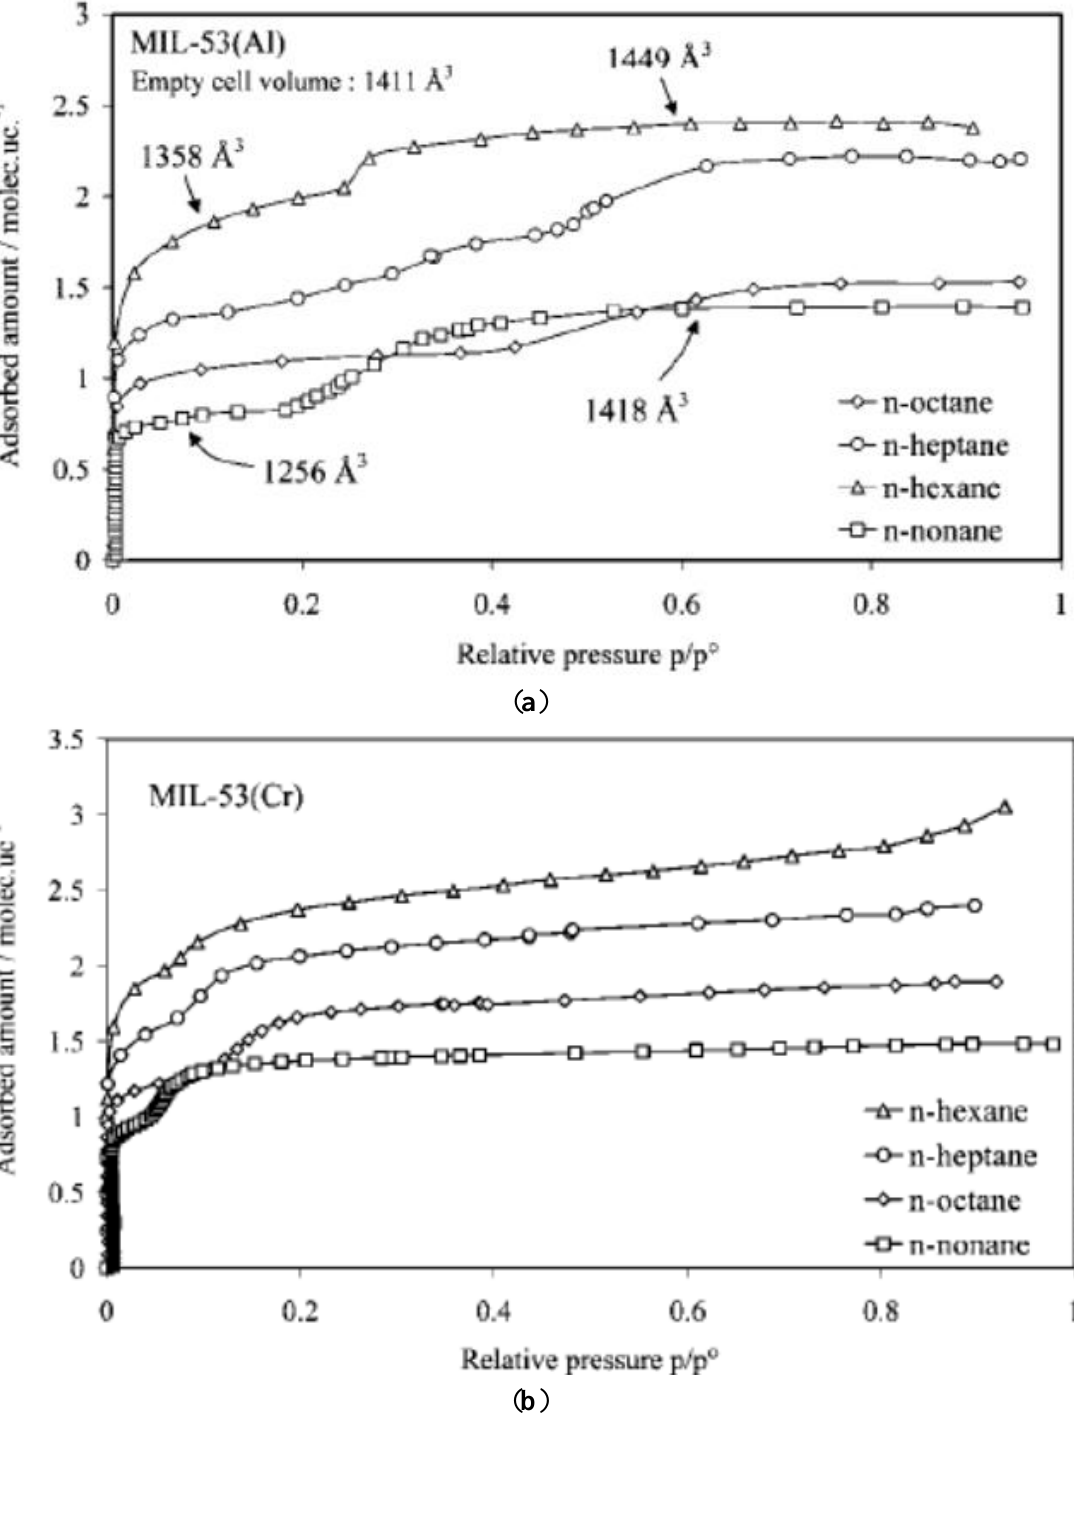
Figure 14. Adsorption isotherms of n -alkanes at 313 K. ( a ) MIL-53(Al); ( b ) MIL-53(Cr). Δ: n -hexane; ○: n -heptane; □: n -nonane; ◊: n -octane. Reprinted with permission from [105]. Copyright 2008 American Chemical